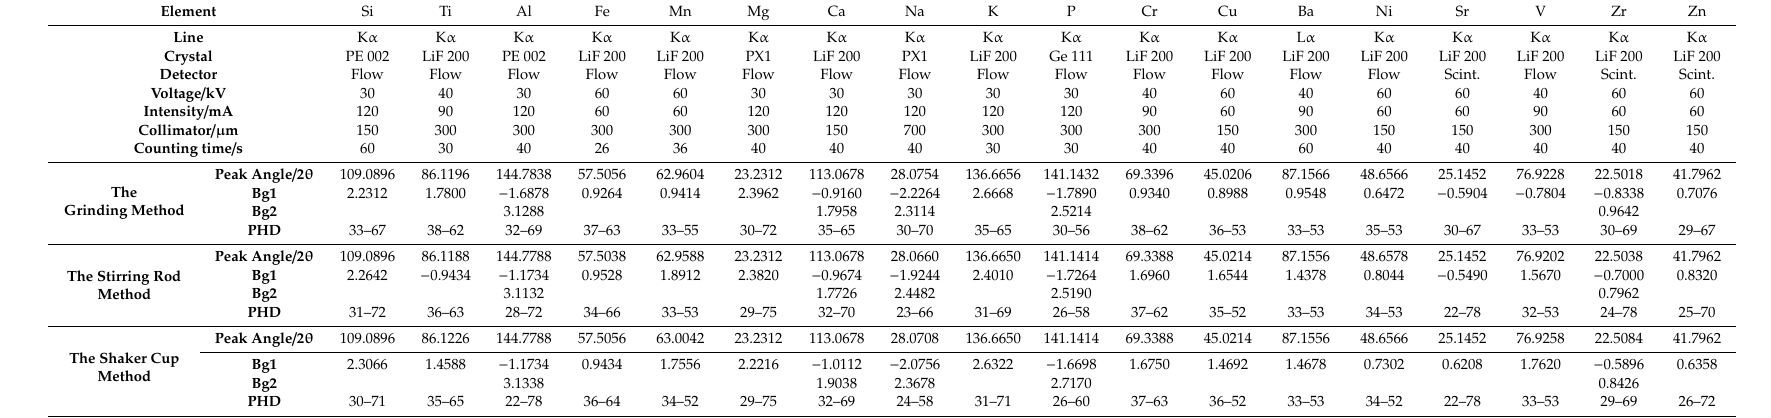
Table 1. Instrumental parameters used in wavelength dispersive X-ray fluorescence spectrometry